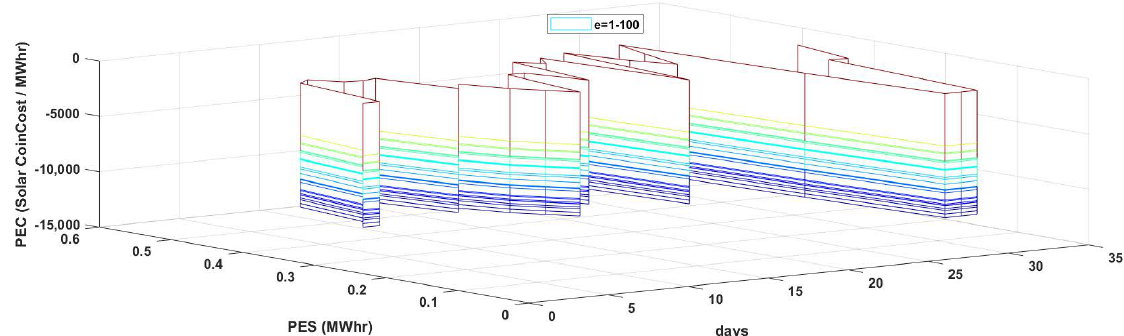
Figure 11. PES and PEC comparison.